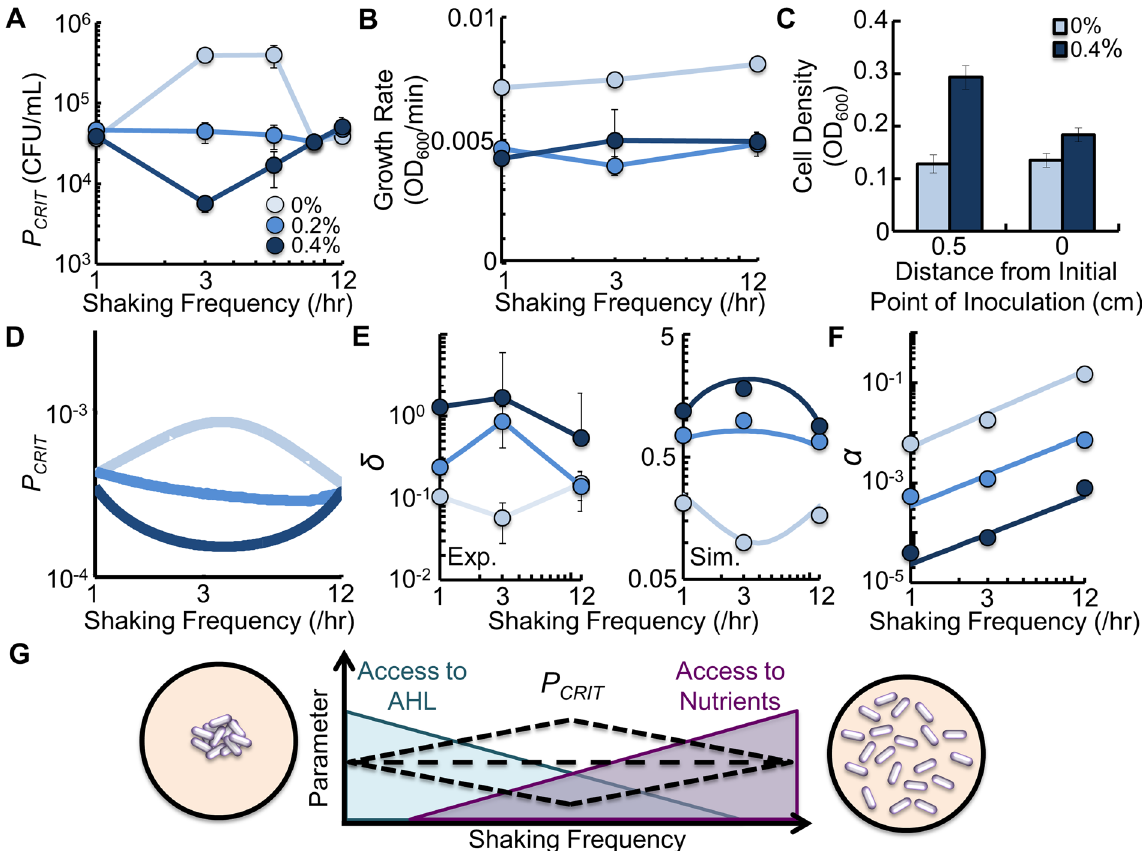
Figure 4. Access to AHL and access to nutrients determines P CRIT during periodic spatial disturbance. ( A ) P CRIT of engineered bacteria shaken at different frequencies and agar densities. At 1/hr, 9/hr and 12/hr, P CRIT was identical in all agar densities ( p ≥ 0.36). At 3/hr and 6/hr, P CRIT decreased with increasing agar density ( p ≤ 0.04). Raw data in Supplementary Fig. S1. P CRIT as a function of δ in Supplementary Fig. S2. Two-tailed t-tests for P CRIT in Supplementary Tables S1 and S2. For panels with experimental data, SD from a minimum of three biological replicates. ( B ) Growth rate of engineered bacteria at different frequencies and agar densities. Bacteria in medium with 0% agar had a higher growth rate than bacteria in 0.2% and 0.4% agar ( p ≤ 0.002, two-tailed t-test). p = 0.53 when 0.2% and 0.4% agar are compared to each other. ( C ) OD 600 reached by bacteria after growing for 16 hours in medium obtained from previous cultures with 0% and 0.4% agar. In both cases, the medium was obtained at 0 cm and 0.5 cm from the initial point of inoculation. In 0% agar, OD 600 was the same after 16 hours ( p = 0.574). In 0.4% agar, OD 600 was higher in the sample taken 0.5 cm away from the initial point of inoculation ( p = 0.004, Methods and Supplementary Results). ( D ) Simulation results demonstrating how P CRIT is affected by shaking frequency (Equations (1–3), see Methods). ( E ) Values of δ from experimental data (left panel) and in our model (right panel, see Methods). For experimental data, p ≤ 0.05 for comparisons within and between different frequencies and agar densities except p = 0.27 when 1/hr and 12/hr are compared in medium with 0.4% agar (two-tailed t-test). ( F ) Values of α in our model that were qualitatively fit to Fig. 2C (see Supplementary Results). ( G ) Schematic of mechanism. With low shaking frequency, bacteria are clustered, increasing AHL access but reducing nutrients access through increased competition. With high shaking frequency, AHL access is reduced, but access to nutrient is increased through decreased competition. The non- linearity of these opposing trends cause changes in P CRIT at intermediate shaking